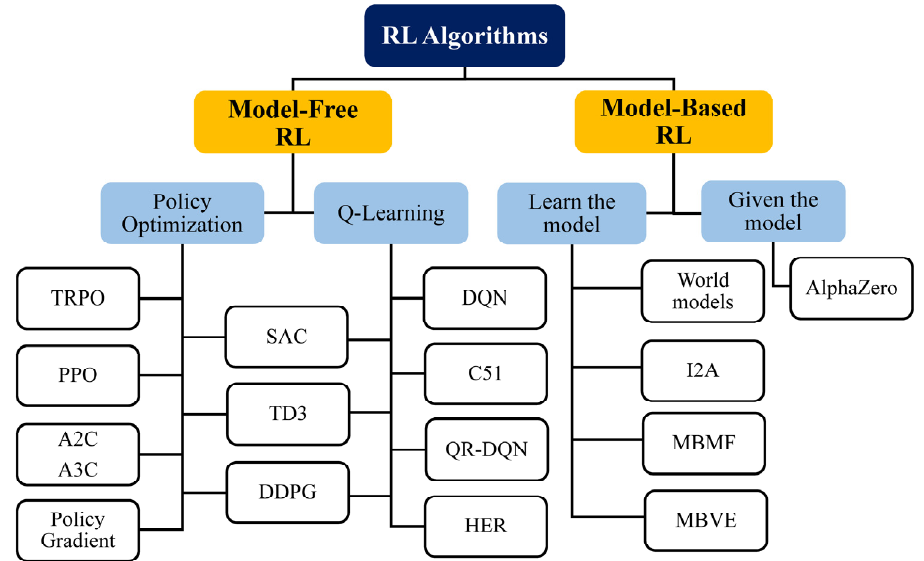
Figure 6. Reinforcement learning (RL) categorization (all the abbreviations are provided in the no- menclature). the